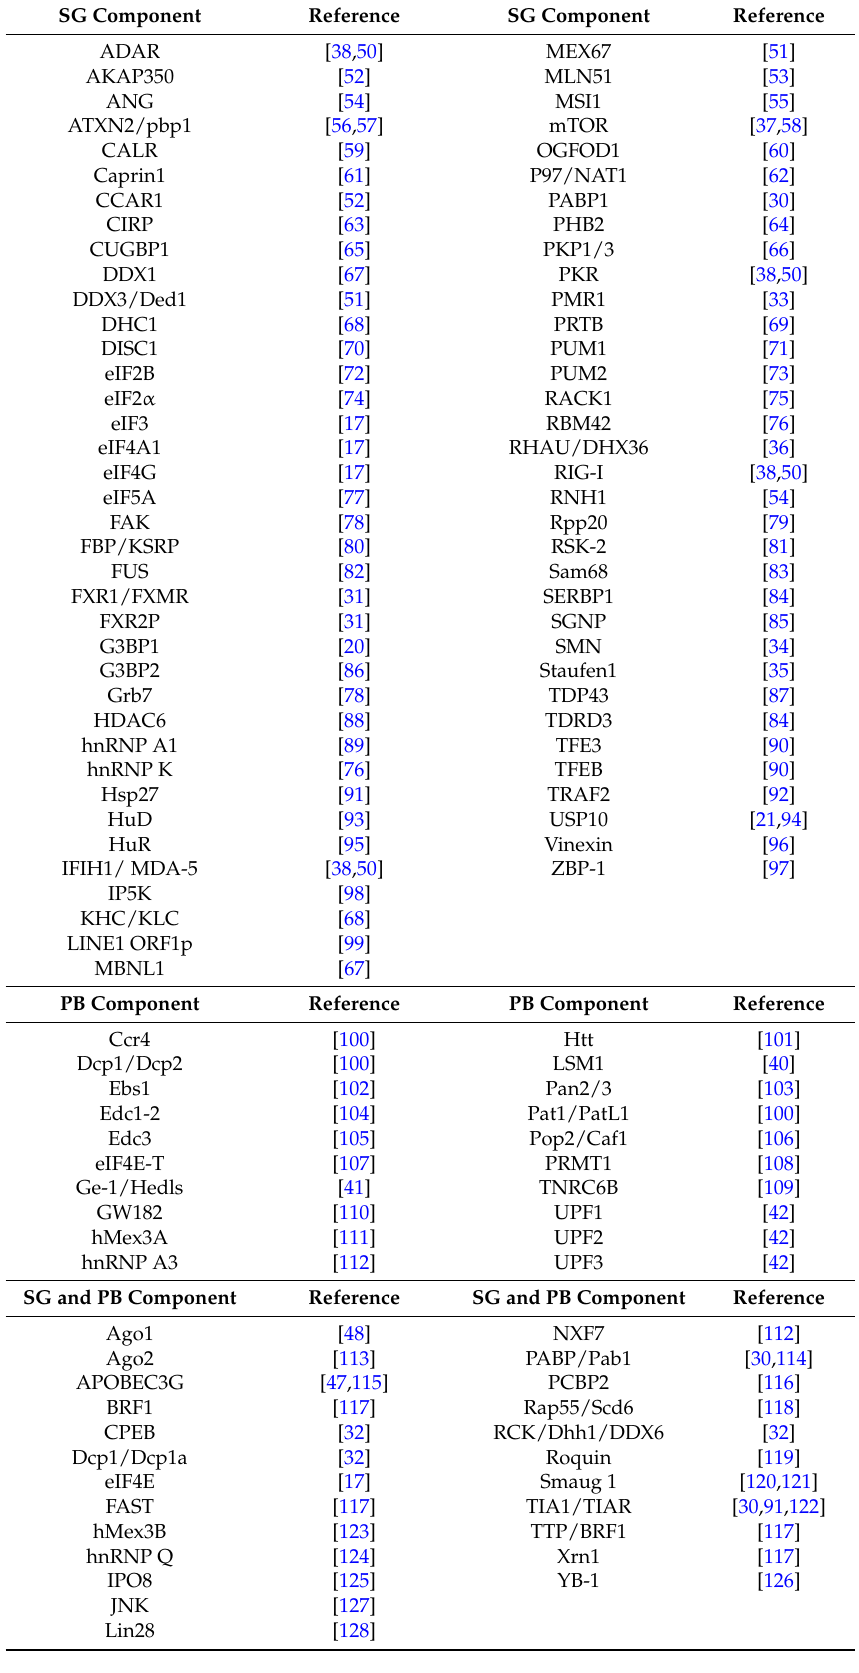
Table 1. Components of stress granules (SGs) and processing bodies